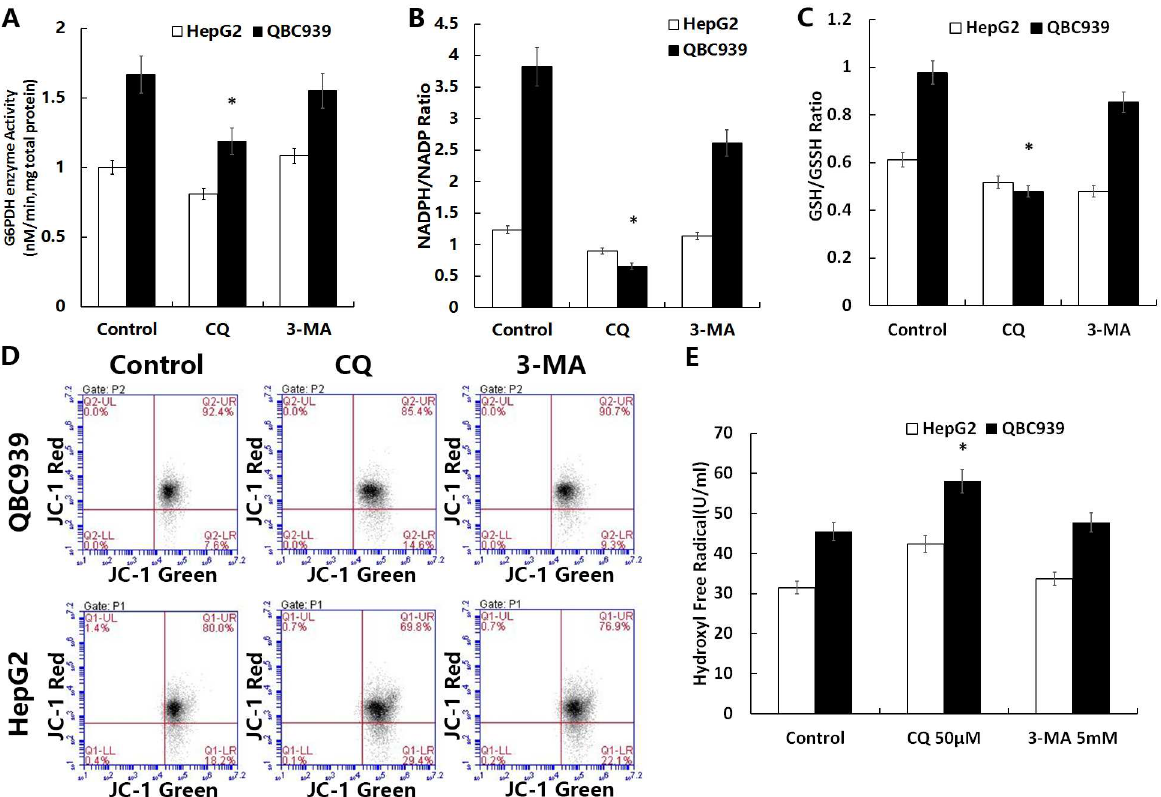
Fig 7. CQ reduced the glucose metabolism-related antioxidant capacity and mitochondrial membranepotential in QBC939 cells and increases the amount of intracellular hydroxyl free radicals. Cells were treated with CQ (50 μ M) or 3-MA (5 mM) for 6 h and then assayed for (A) intracellularG6PDH activity, (B) the NADPH/NADP ratio, and (C) GSH/GSSG ratio. (D) Cells treated with CQ (50 μ M) or 3-MA (5 mM) were incubatedfor 8 h and then assayed for the mitochondrial membranepotentialwith JC-1 by flow cytometry (fluorescence intensity: x axis, green; y axis, red). (E) Cells treated with CQ (50 μ M) or 3-MA (5 mM) were incubatedfor 24 h and then assayed for the amount of intracellularhydroxyl free radicals.All values are the mean ± SE. * p < 0.05betweencontrol and other group in QBC939